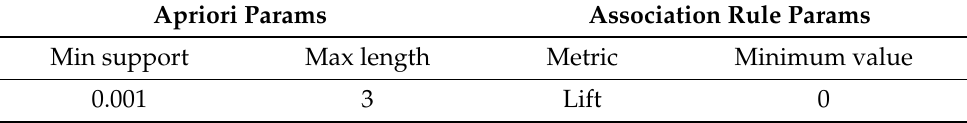
Table 4. ARM algorithm